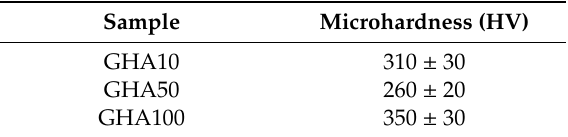
Table 2. Microhardness values measured for all the anodized samples.